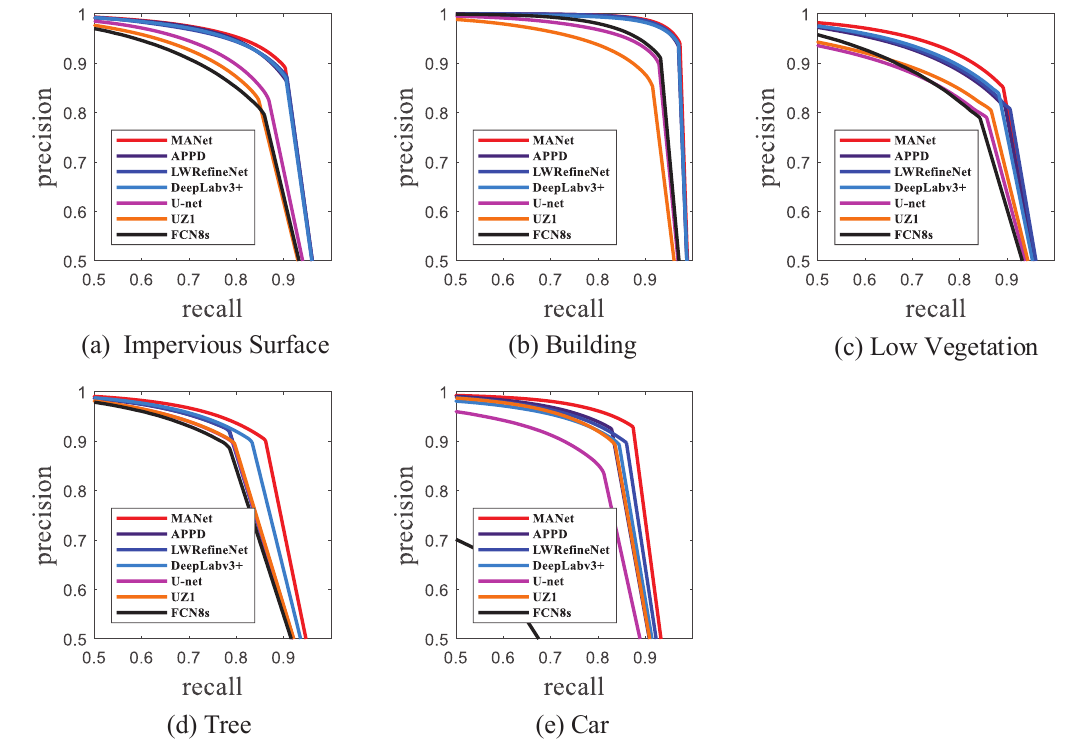
Figure 5. Precision-recall (PR) curves for each category of the seven models on the Potsdam